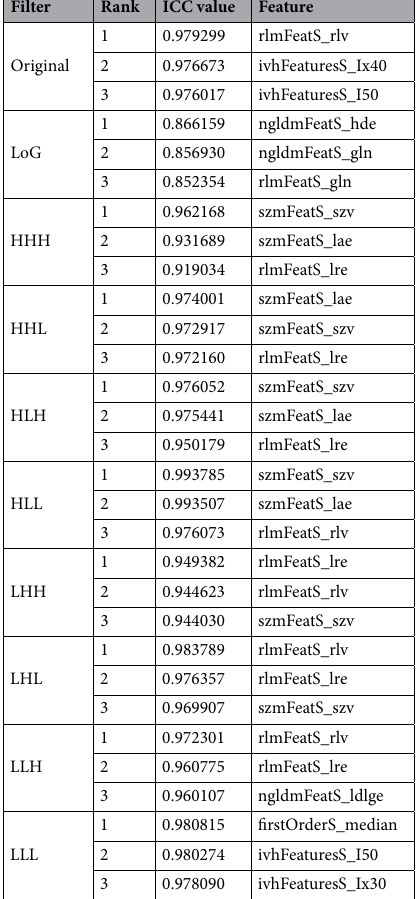
Table 3. ICC values of top 3 features for radiation oncologist derived contours per filtered image. Feature definitions and calculation provided by Computational Environment for Radiological Research (CERR) 35 , as recommended by the imaging biomarker standardization initiative (IBSI) 36